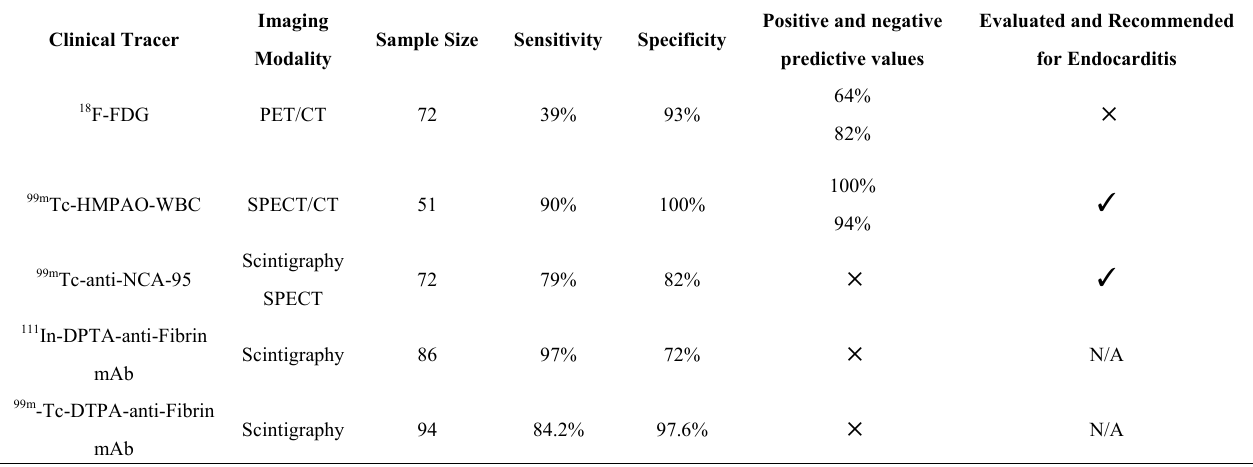
Table 2. A summary of the clinical radiopharmaceuticals applicable to the imaging of endocarditis. Clinical